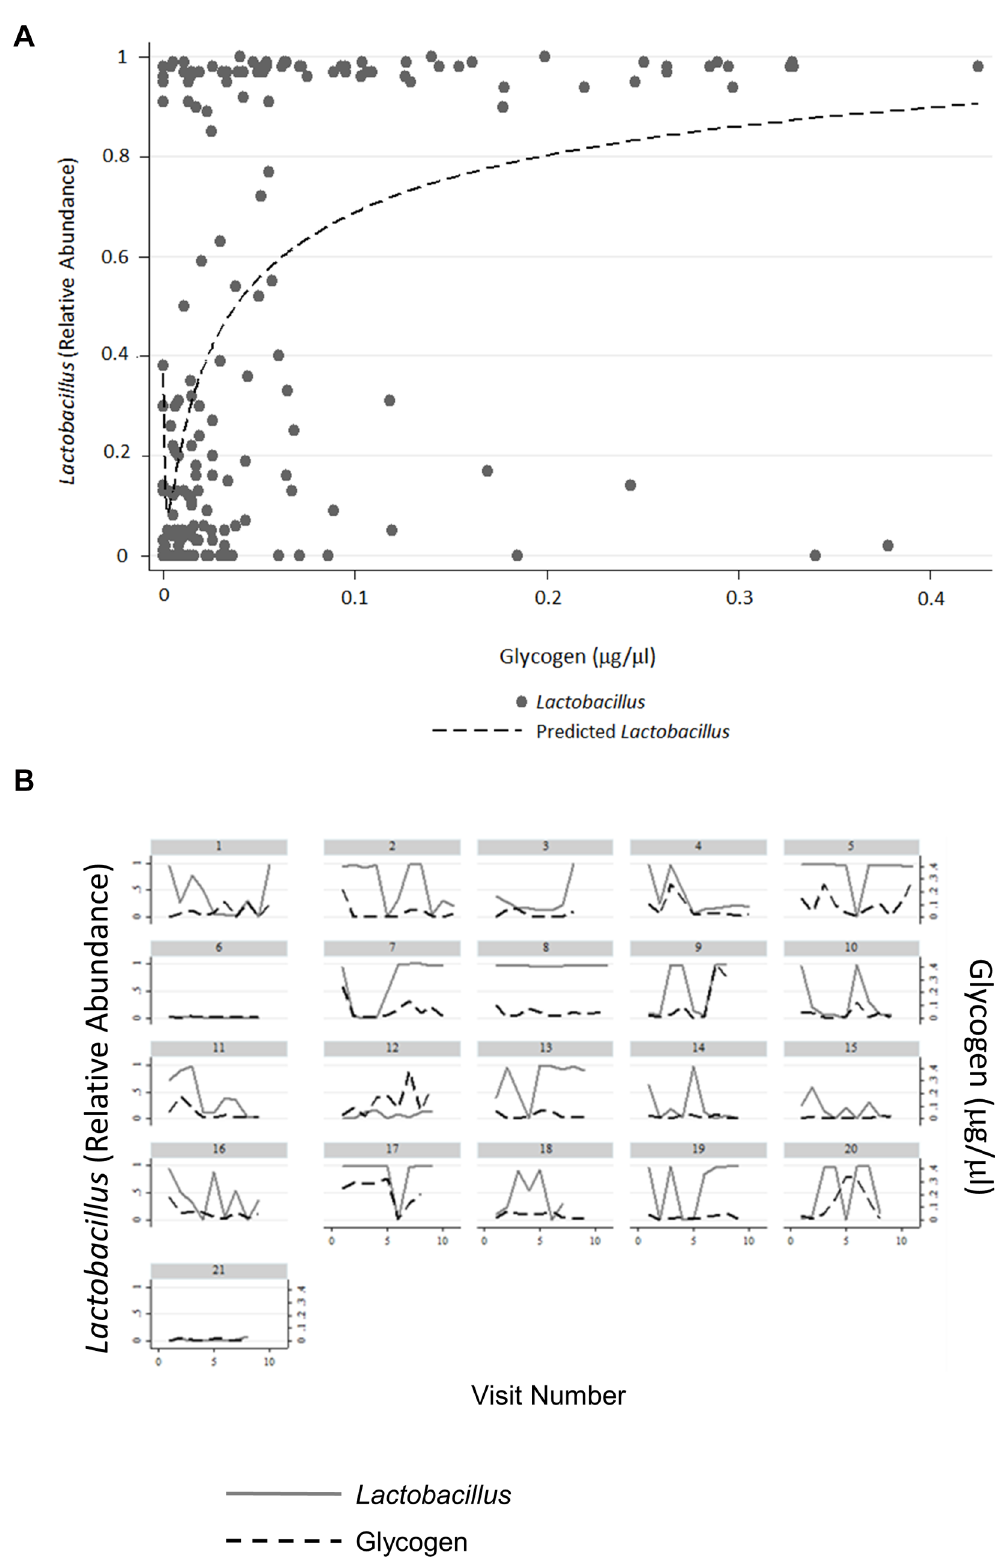
Figure 1. Distribution of Relative Abundance of Lactobacillus by Glycogen Concentration. Glycogen levels were measured in vaginal fluids collected annually from 21 women over 8–11 years. (A) The final analytic sample consisted of 177 observations with non-missing values for both glycogen and Lactobacillus . The distribution of Lactobacillus relative abundance is summarized by glycogen as a continuous variable. (B) The relative abundance of Lactobacillus and concentration of glycogen over time by participant. Left Y axis is relative abundance of Lactobacillus ; right Y axis is glycogen concentration ( m g/ m l). X-axis is annual visit number. doi:10.1371/journal.pone.0102467.g001 PLOS ONE | www.plosone.org 5 July 2014 | Volume 9 | Issue 7 |